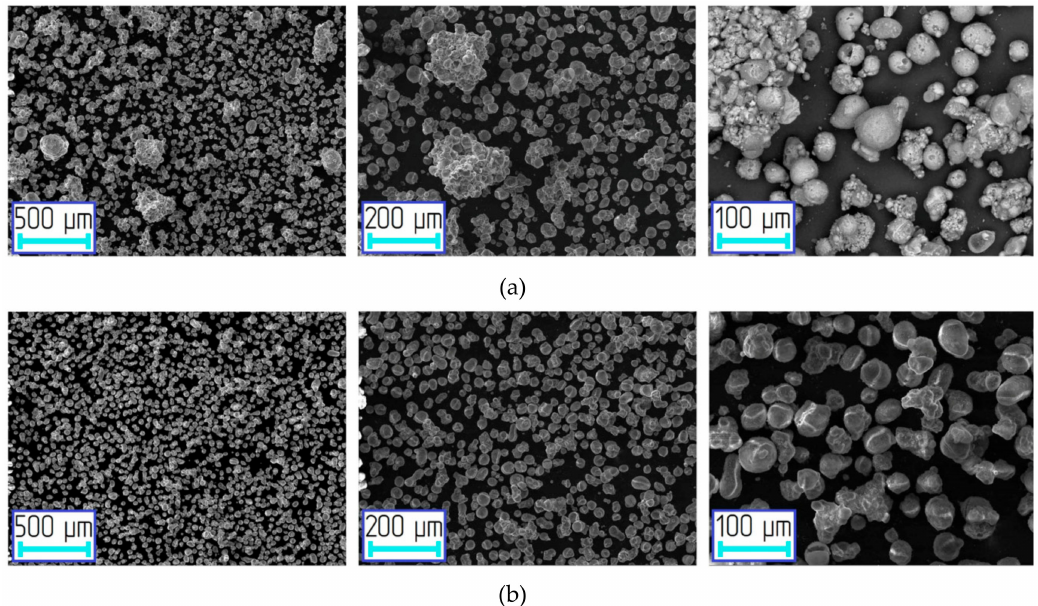
Figure 6. SEM images of the oxidized aluminum powders at di ff erent modes (after drying and calcination processes): ( a ) A, ( b )